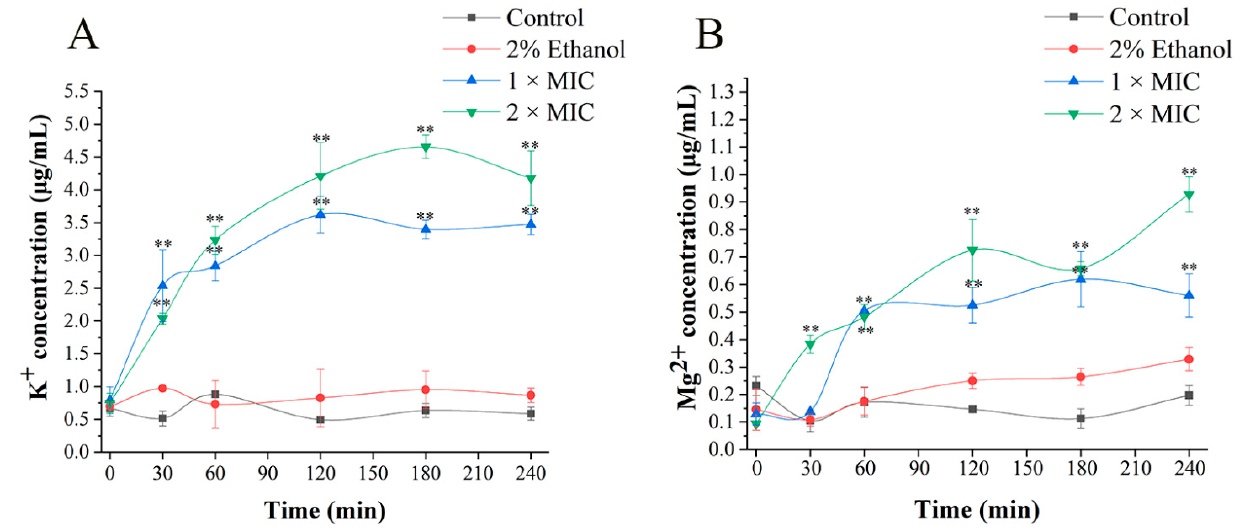
Figure 4. Effect of 3-carene on the concentration of extracellular K + ( A ) and Mg 2+ ( B ). The asterisks indicate statistically significant differences compared with the control (** p < 0.01).